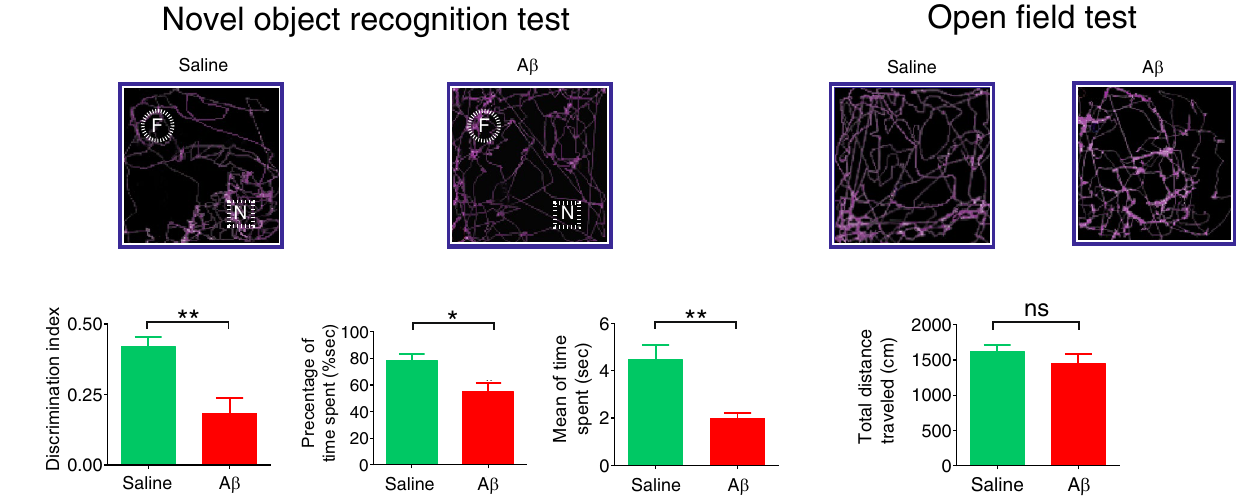
Figure 4. Aβ animals showed recognition memory impairment. (Left) Top panels indicate tracking points during the NOR task. The bottom panels denote that the preference ratio for the novel object was significantly attenuated in Aβ animals, measured by discrimination index, percentage by time spent, and mean of time spent. (Right) Aβ and saline animals showed no significant differences in the total traveled distance as an indicator of locomotor activity. Bar graphs represent mean ± SEM. The comparison was conducted by t-test, n = 6 per group. * p < 0.05, ** p < 0.01, *** p < 0.001, **** p < 0.0001 Aβ compared to saline. Aβ amyloid-beta, F familiar object, N novel object, NOR novel object